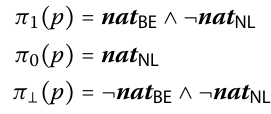
Fig. 2 b ( π 0 ( p ) ) and Fig. 2 c ( π (cid:7) ( p ) ). In the figures, solid arrows indicate that the path of the BDD in case a given attribute value is present in the query (i.e., the